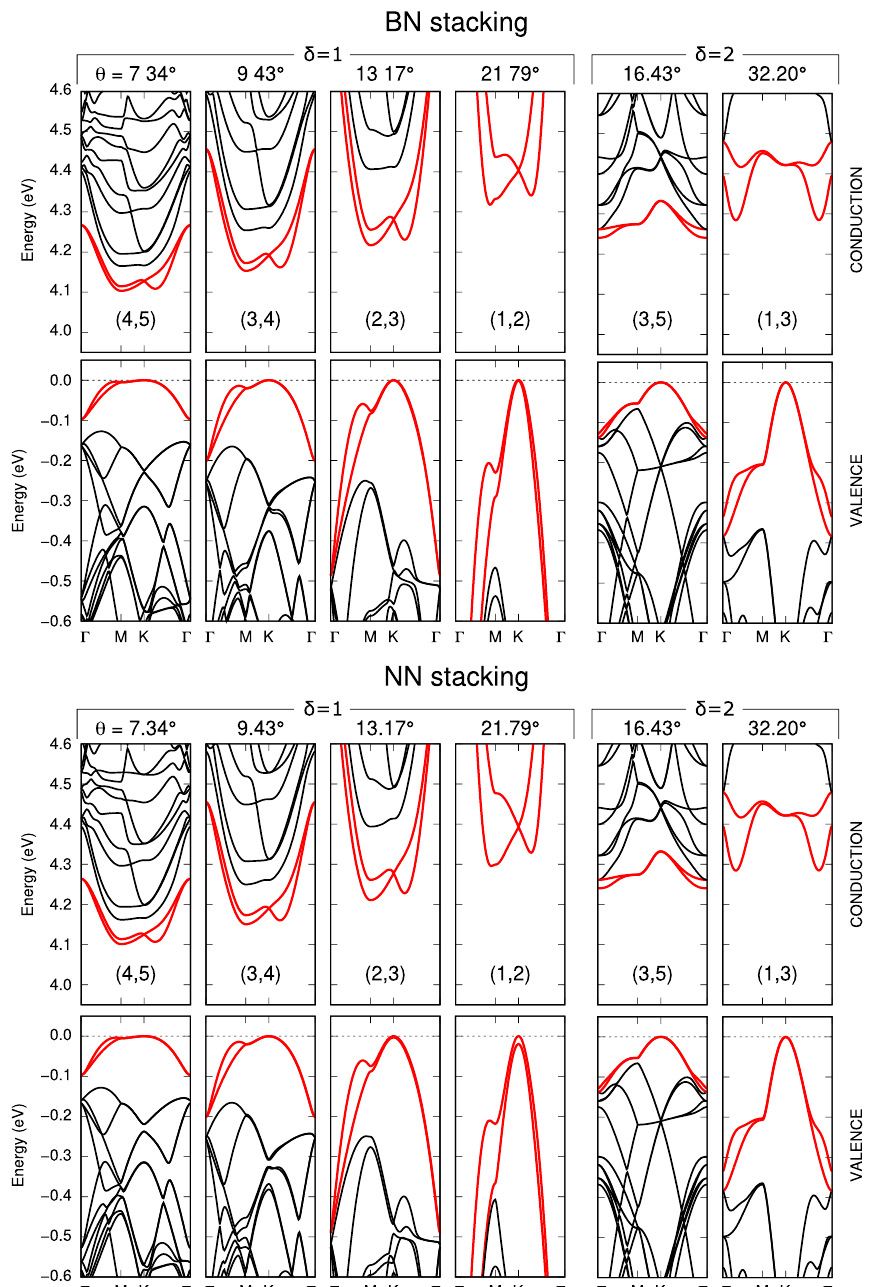
Figure 5: Bottom conduction and top valence of the BN (top panel) and NN (bottom panel) stackings at different twist